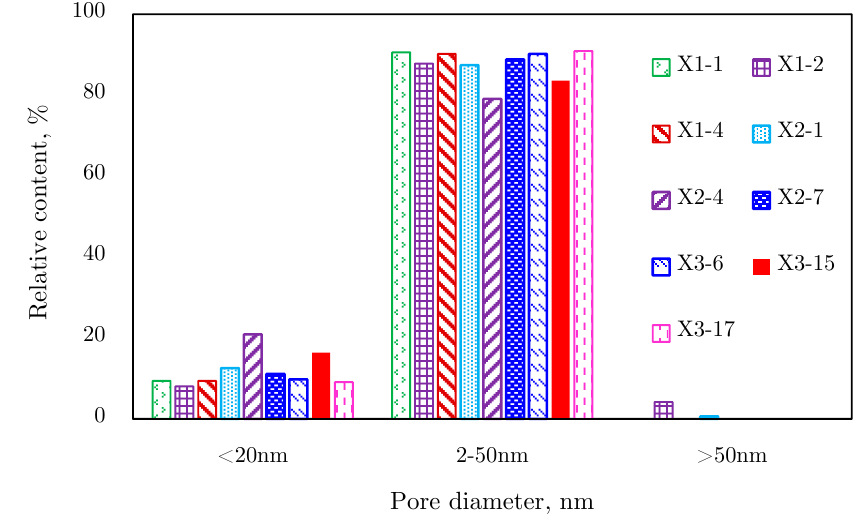
Figure 10. PSD histogram of samples from the Longmaxi Formation in Sichuan Basin based on N 2 adsorption.